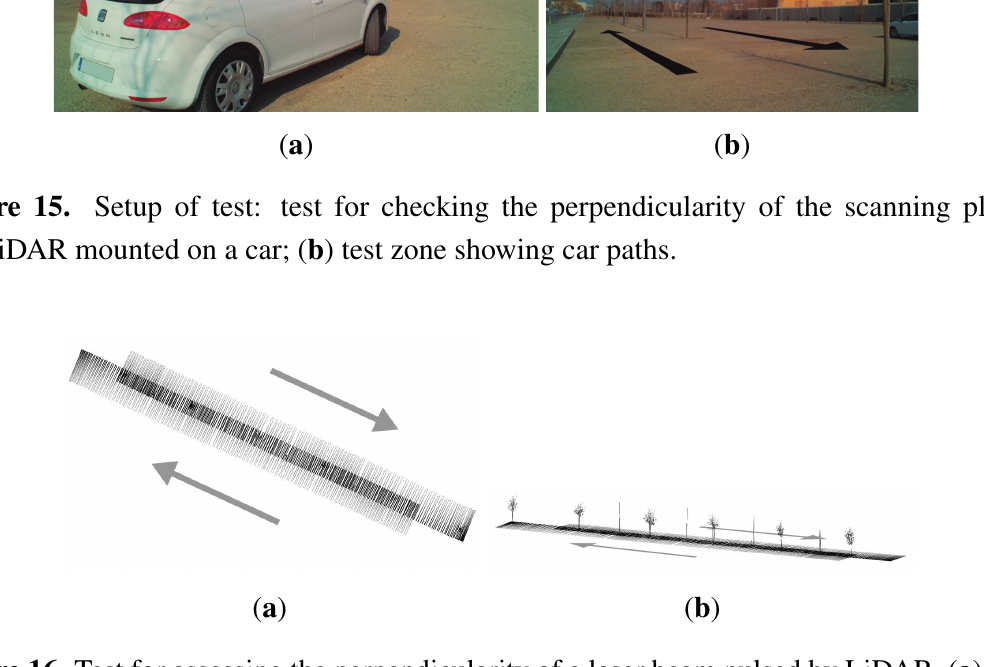
Figure 16. Test for assessing the perpendicularity of a laser beam pulsed by LiDAR. ( a ) Top view of resulting cloud; ( b ) axonometric view of resulting